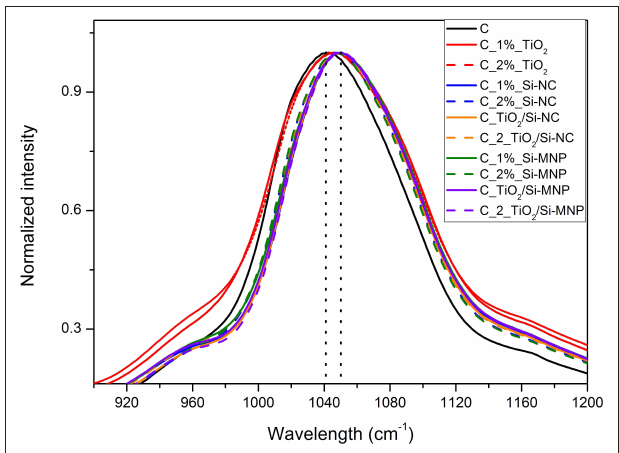
FIGURE 5 | Detail of the Si-O-Si infrared band for the all coatings. The dot lines highlight the shift in the principal component from the empty coating to the coating with nanoparticles. TABLE 5 | Shift and assignments of the bands observed in the spectra of the coatings.